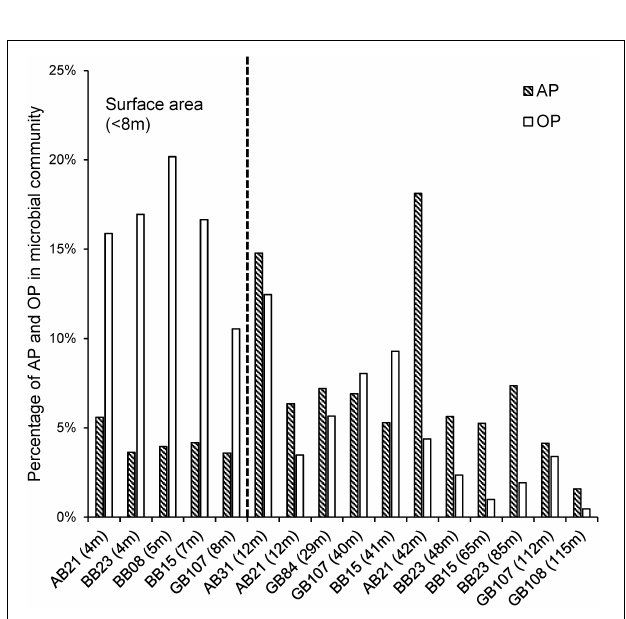
FIGURE 5 | Relative abundance of AP and OP (Cyanobacteria) in microbial community in the Baltic Sea.